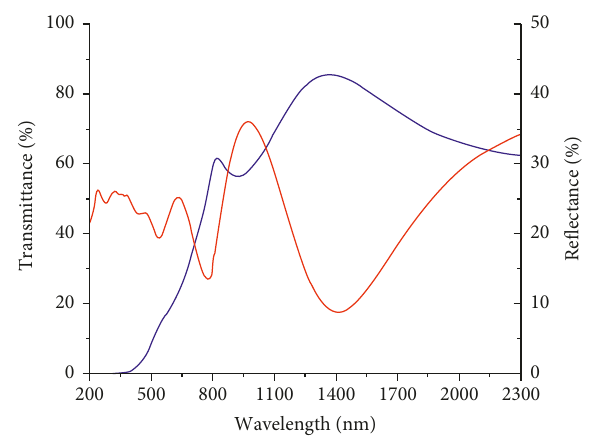
Figure 8: Optical transmittance spectra and optical reflectance spectra of CZTS assembly synthetized with 0.324g of PVP and deposited through thermal evaporation on glass substrate.